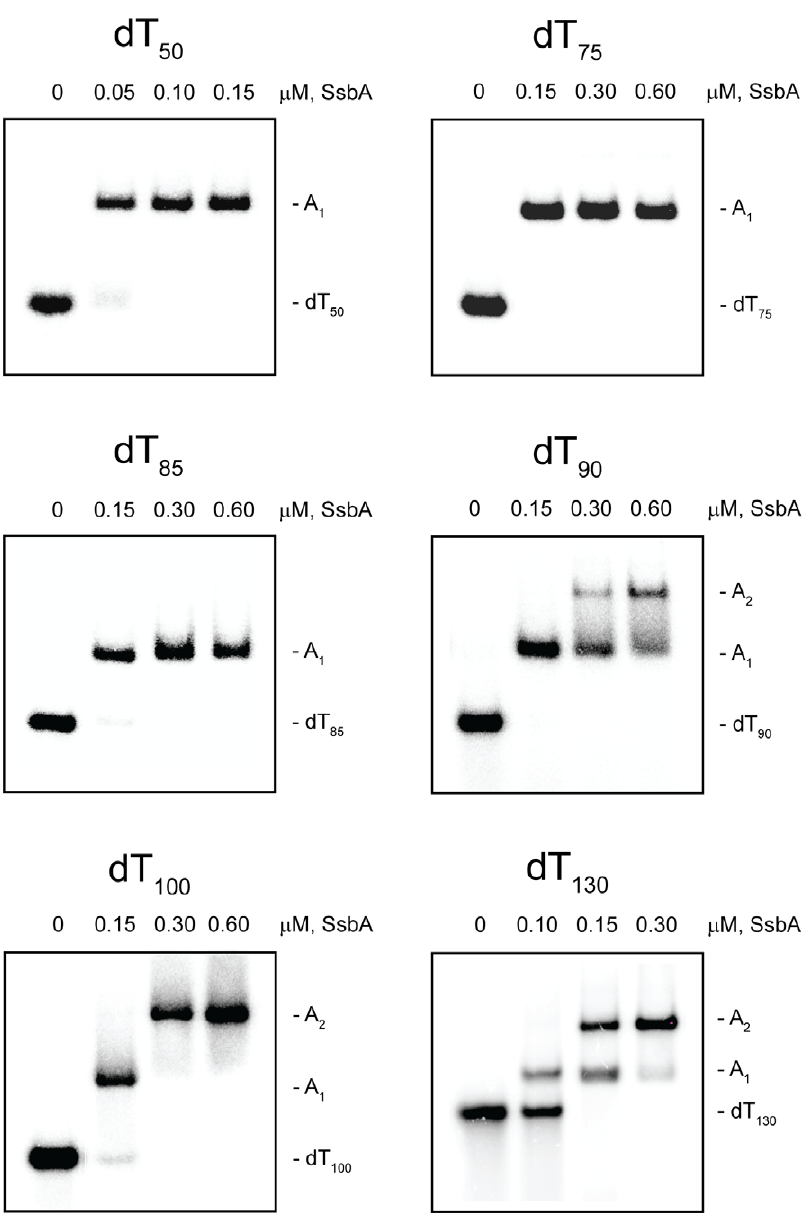
Figure 3. Binding of SsbA protein to dT n oligomers in the presence of Mg 2 + . The reaction solutions contained 25 mM Tris acetate (pH 7.5), 10 mM magnesium acetate, 5 m M dT n (nucleotide concentration), and the indicated concentrations of SsbA protein (tetramer concentrations). The reactions were analyzed by polyacrylamide gel electrophoresis using a gel running buffer consisting of Tris acetate (pH 7.5) and 10 mM magnesium acetate. The bands corresponding to the unbound dT n oligomers, and the A 1 and A 2 complexes, were visualized by phosphorimaging.